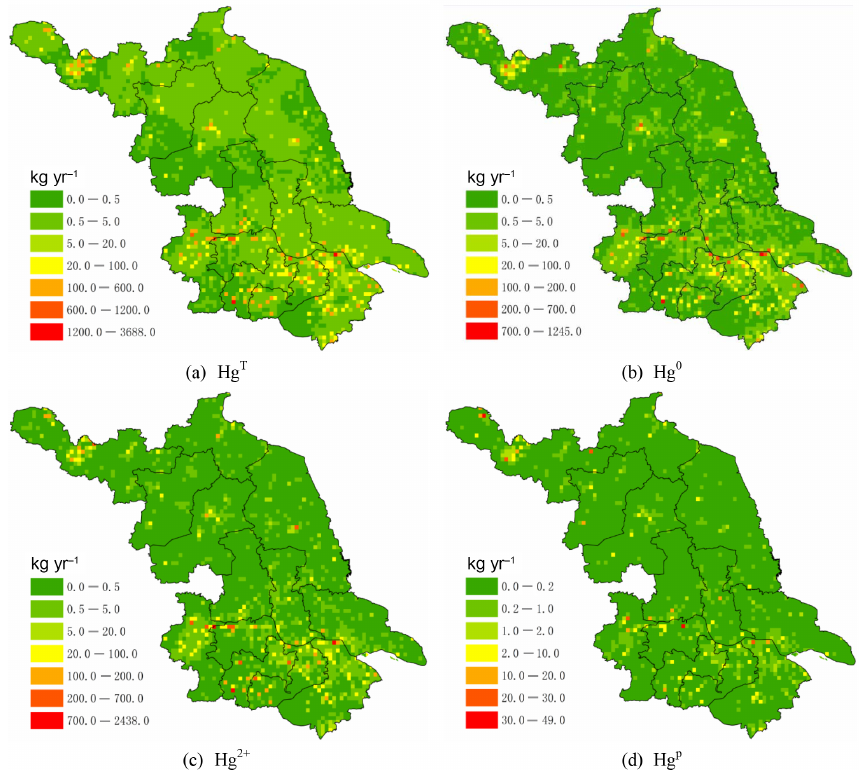
Figure 3. Spatial distribution of Hg emissions for Jiangsu 2010 at a resolution of 0.05 ◦ × 0.05 ◦ for (a) Hg T , (b) Hg 0 , (c) Hg 2 + , and (d) Hg p